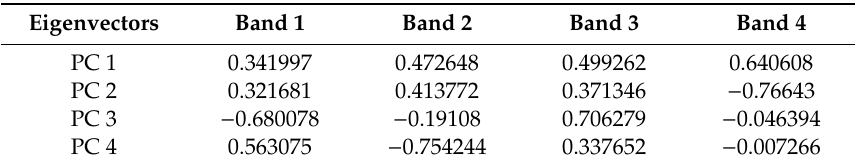
Table 1. Eigenvectors of the principal component analysis on a spectral subset of the ASTER data for detecting the gossans in the study area.